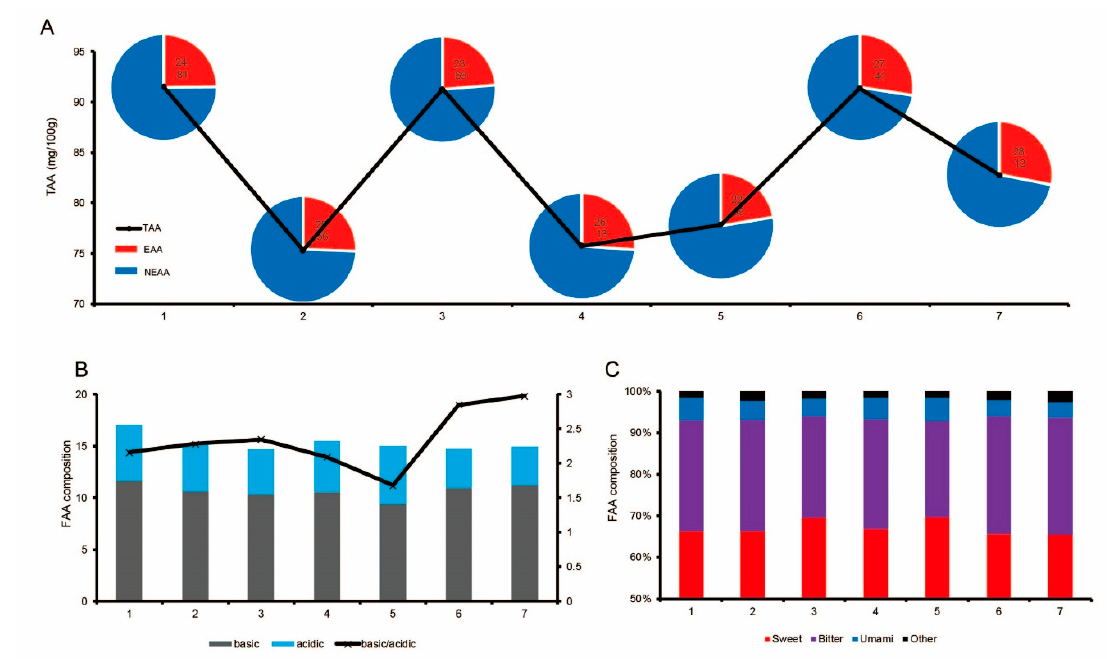
Figure 2. Analysis of amino acid composition in the longissimus dorsi muscle. ( A ) Changes in total amino acid (TAA) content and changes in essential amino acids (EAA) and non-essential amino acids (NEAA). ( B ) The content of basic and acidic amino acids. ( C ) The amino acid ratios of longissimus dorsi muscle with different flavors. Umami AA: Glu, Asp; Sweet AA: Gly, Ala, Ser, Thr, Pro, Gln, Lys; Bitter AA: Tyr, Arg, His, Val, Met, Ile, Leu, Trp, Phe. Table 4. Fatty acid content of the longissimus dorsi muscle of the Liangshan pig (mg / 100g). Phase FA